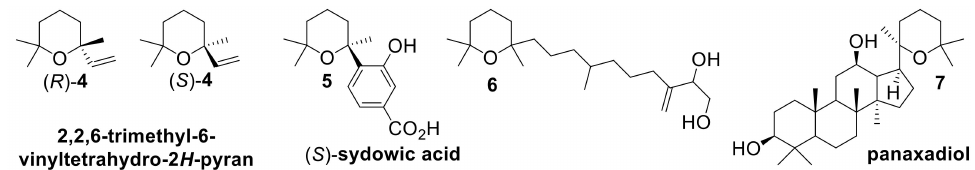
Figure 2. Representative examples of natural terpenes (mono-, sesqui-, di-, and triterpenes) bearing the 2,6,6-trimethyltetrahydro-2 H -pyran-2-yl moiety in their molecular